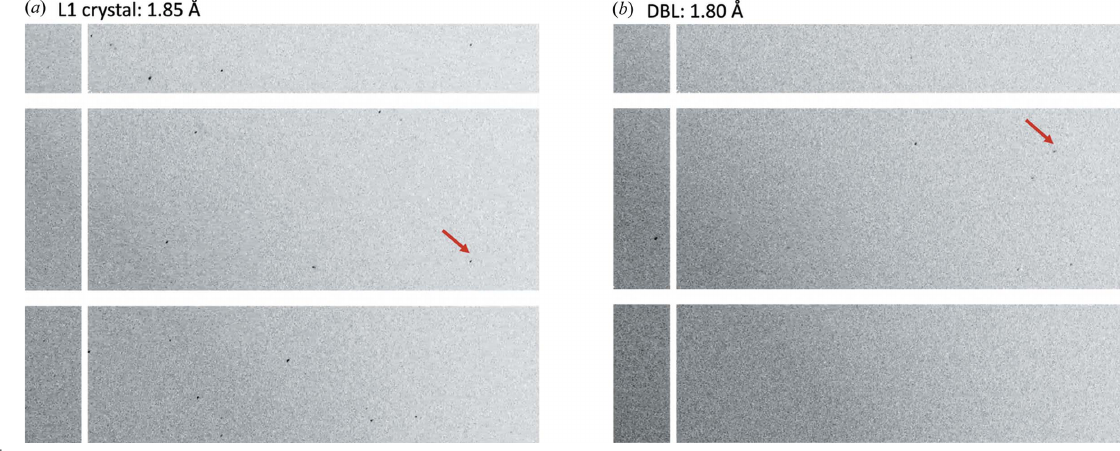
Figure 4 Diffraction patterns obtained from crystals of ( a ) L1 and ( b ) DBL. The arrows point to reflection at the indicated resolution.